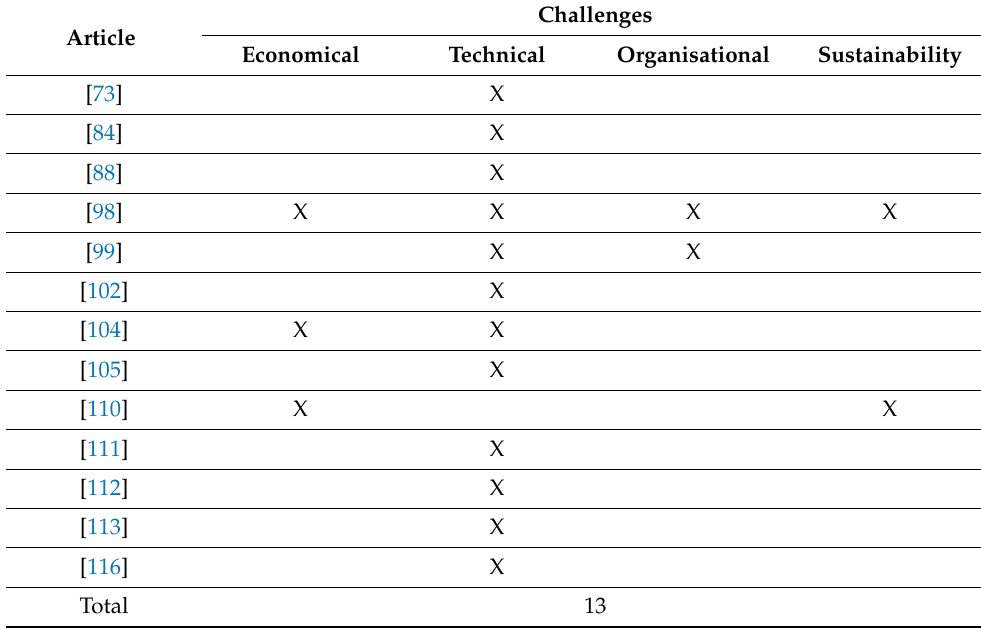
Table 3. Classification results of “Challenges” category. Source: Authors’